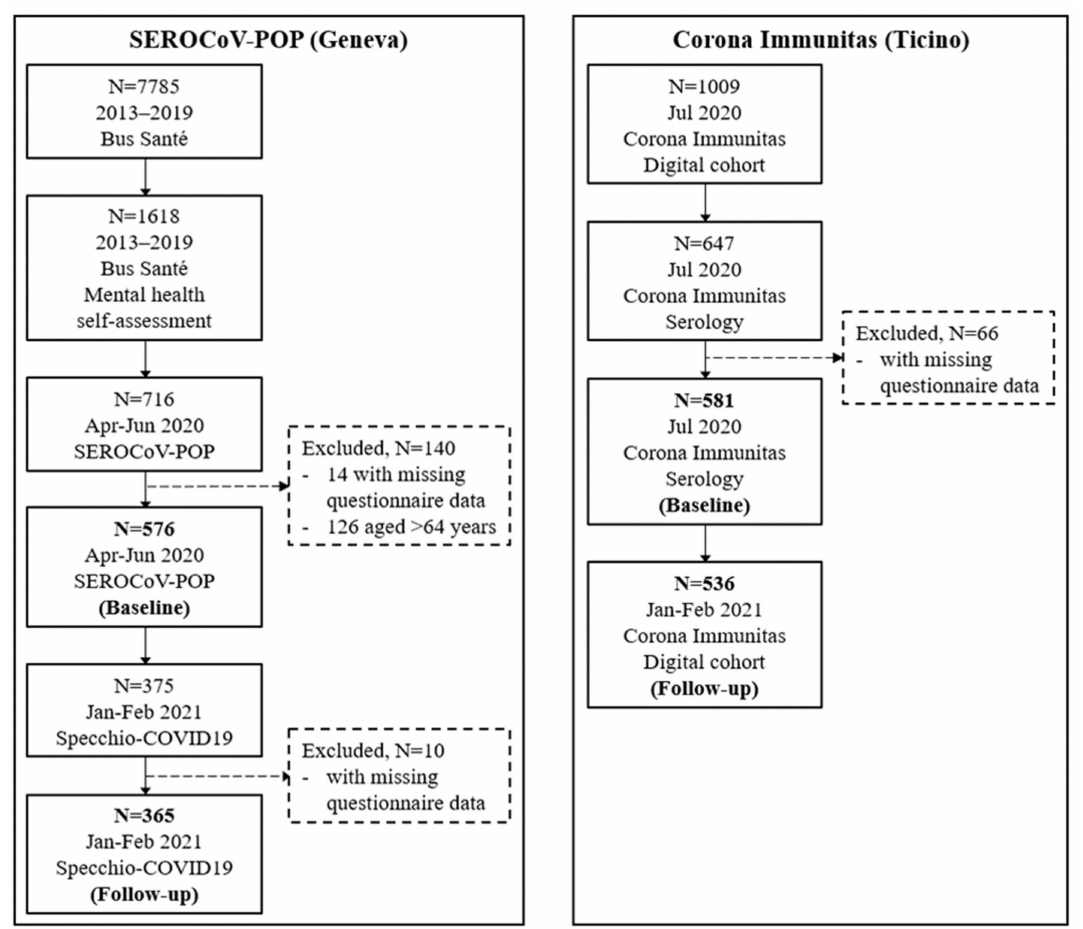
Figure 1. Flow chart for the selection of participants in Geneva and Ticino,